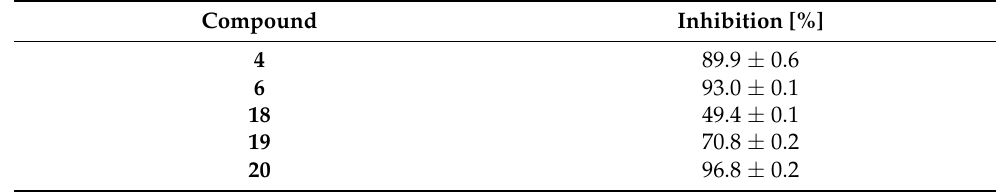
Table 1. Inhibition percentage of conjugates (at 10 µ M concentration) and of standard acetazolamide ( 4 ).